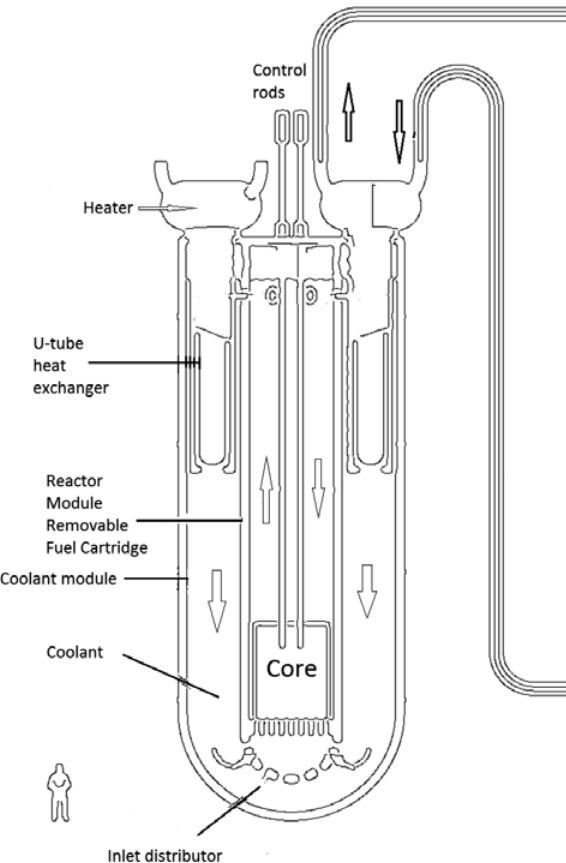
Fig. 4. – Schematic representation of a lead-cooled fast reactor with pool configuration.